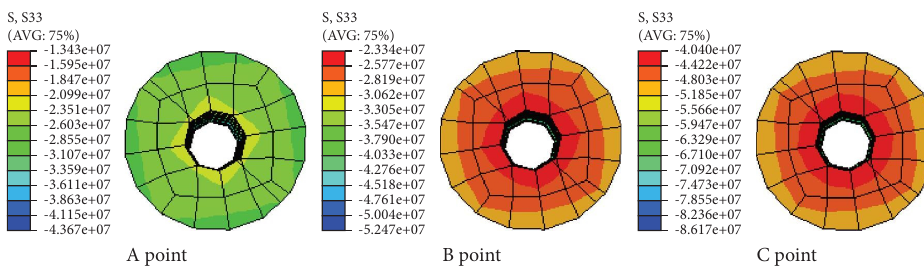
Figure 9: Te stress distribution of